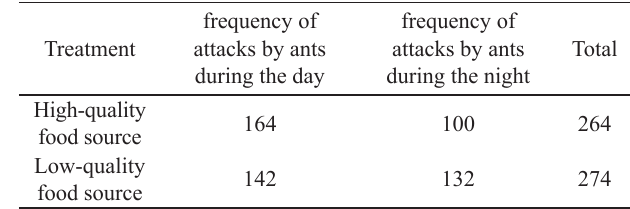
Table 1 . Frequency of attacks by ants on dummy caterpillars near artificial nectaries fixed on the branches of the shrub Prosopis laevigata during day and night and under different food source quality treatments over a